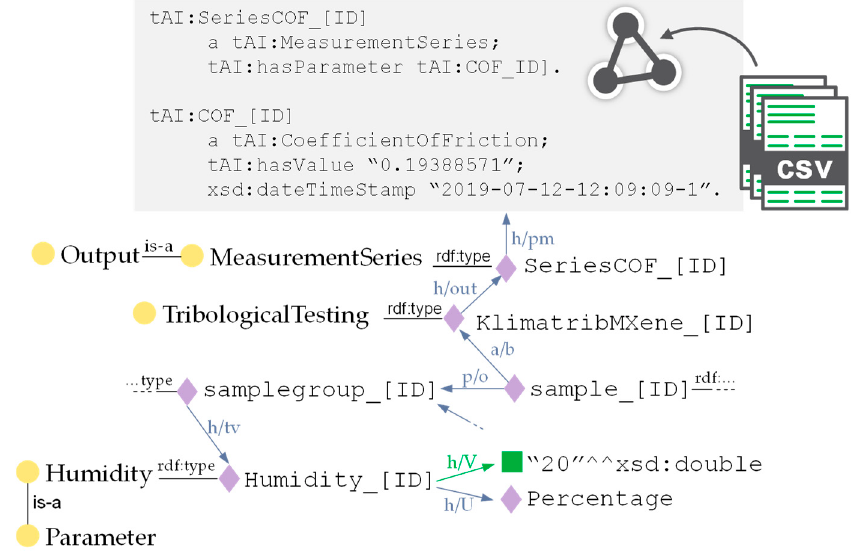
Figure 11. Transforming output data from csv into a triplestore.